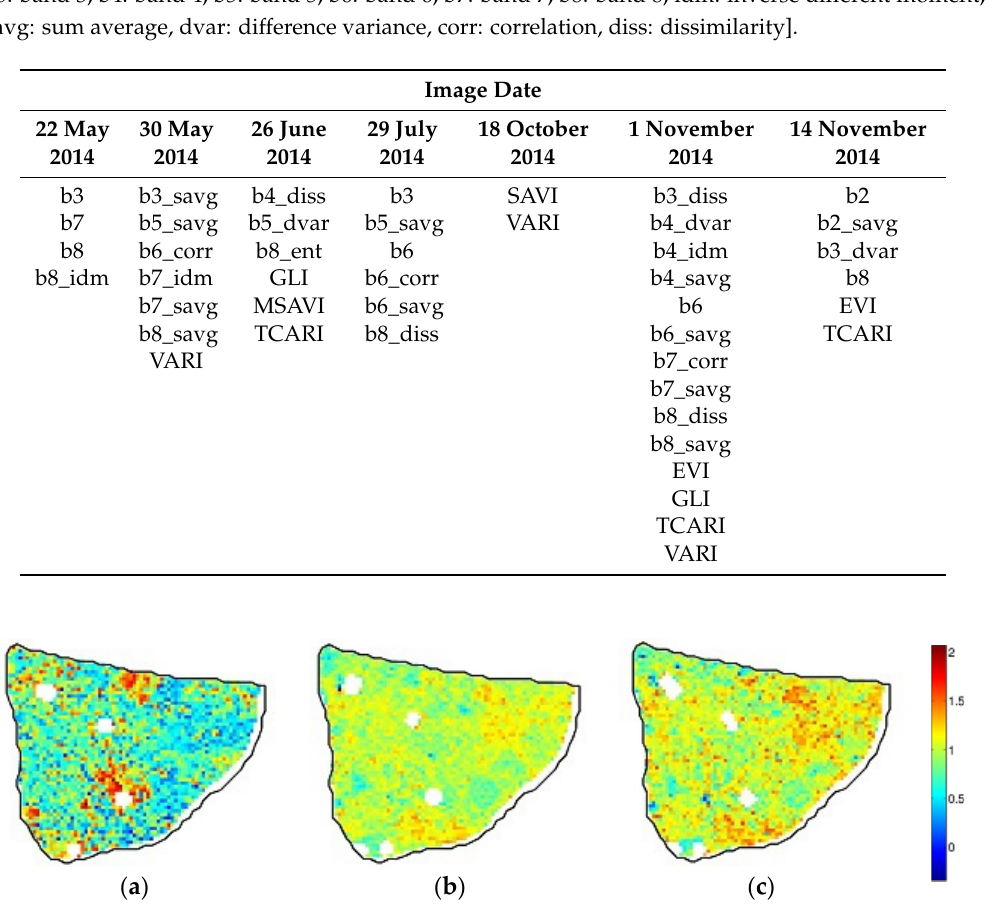
Table 3. Guided regularized random forest (GRRF) selected features sorted by image date [b2: band 2,